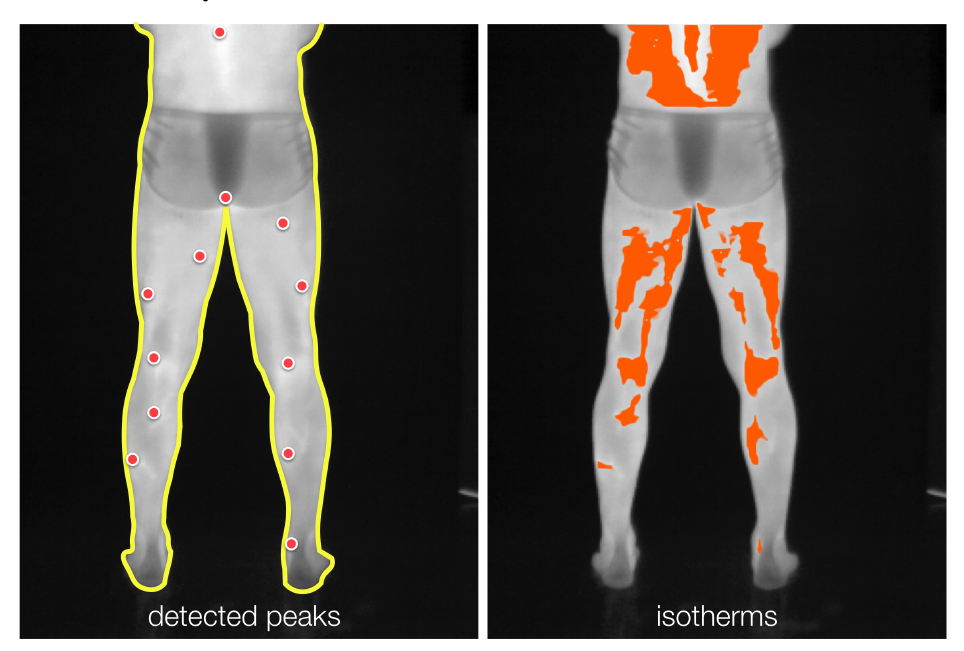
Figure 5. Extracting isotherms. ( Left ) Automatically detected peaks (red dots) serve as seed points; ( right ) hot isotherms are extracted using region growing controlled by a user-defined threshold, for